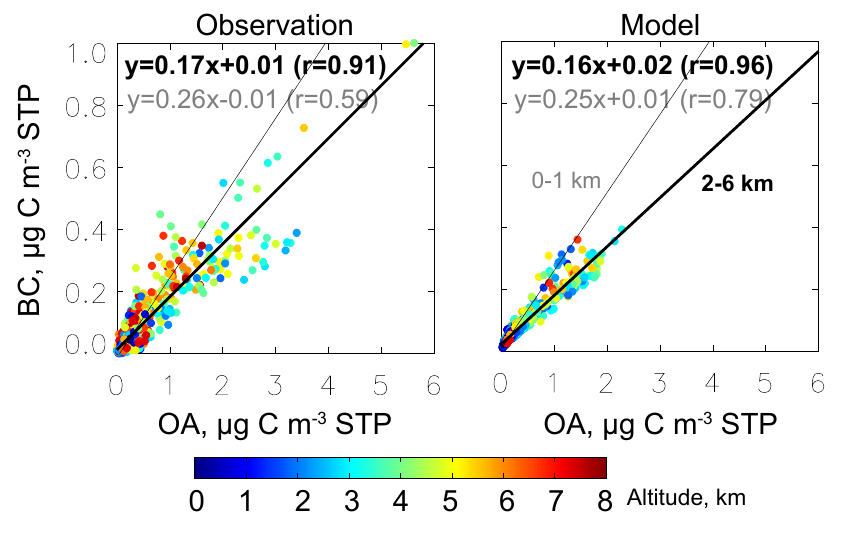
Fig. 9. Same as Fig. 8 but for BC vs. OA concentrations in